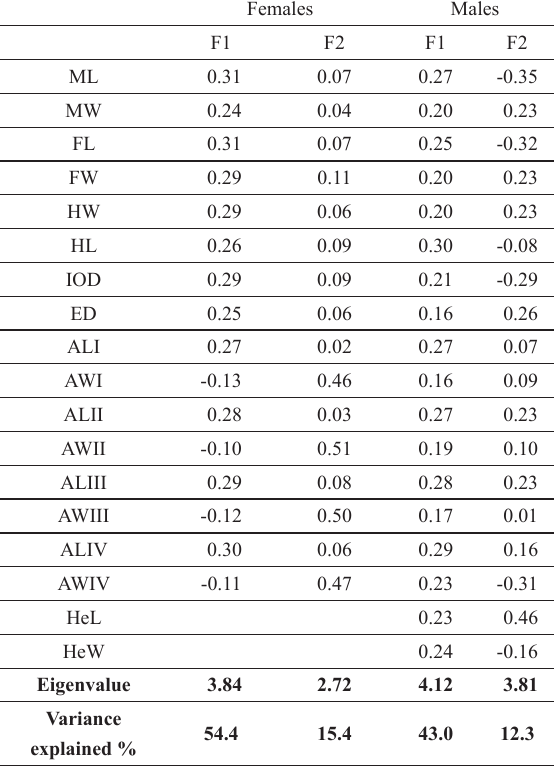
Principal Component Analysis (PCA) applied to morphometric data of Lolliguncula brevis collected off Brazil. Weights of the variables in the first two factors rotated by the PCA (F1 and F2) are indicated for females and males. The eigenvalues and the variance explained by each factor are indicated in the last two